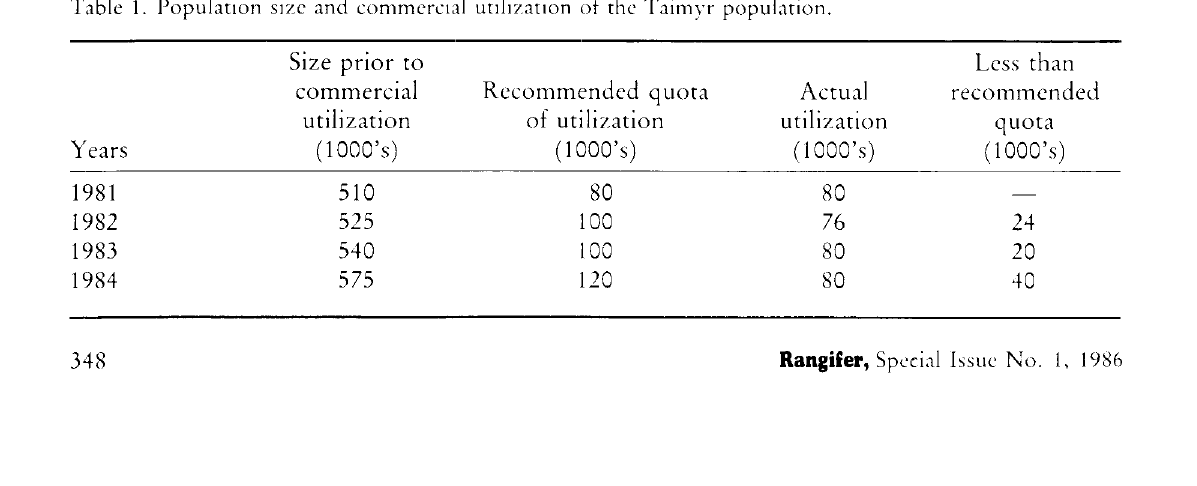
Table 1. Population size and commercial utilization of the Taimyr